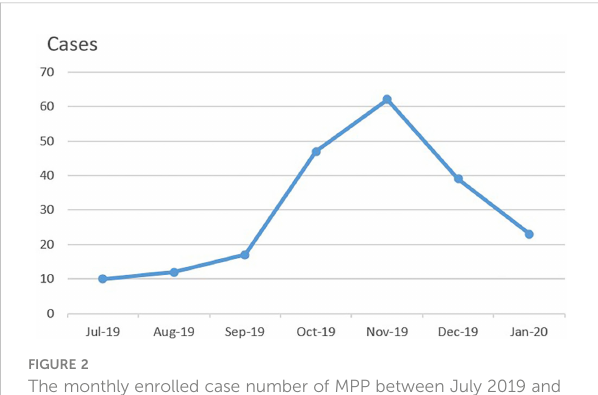
FIGURE 2 The monthly enrolled case number of MPP between July 2019 and